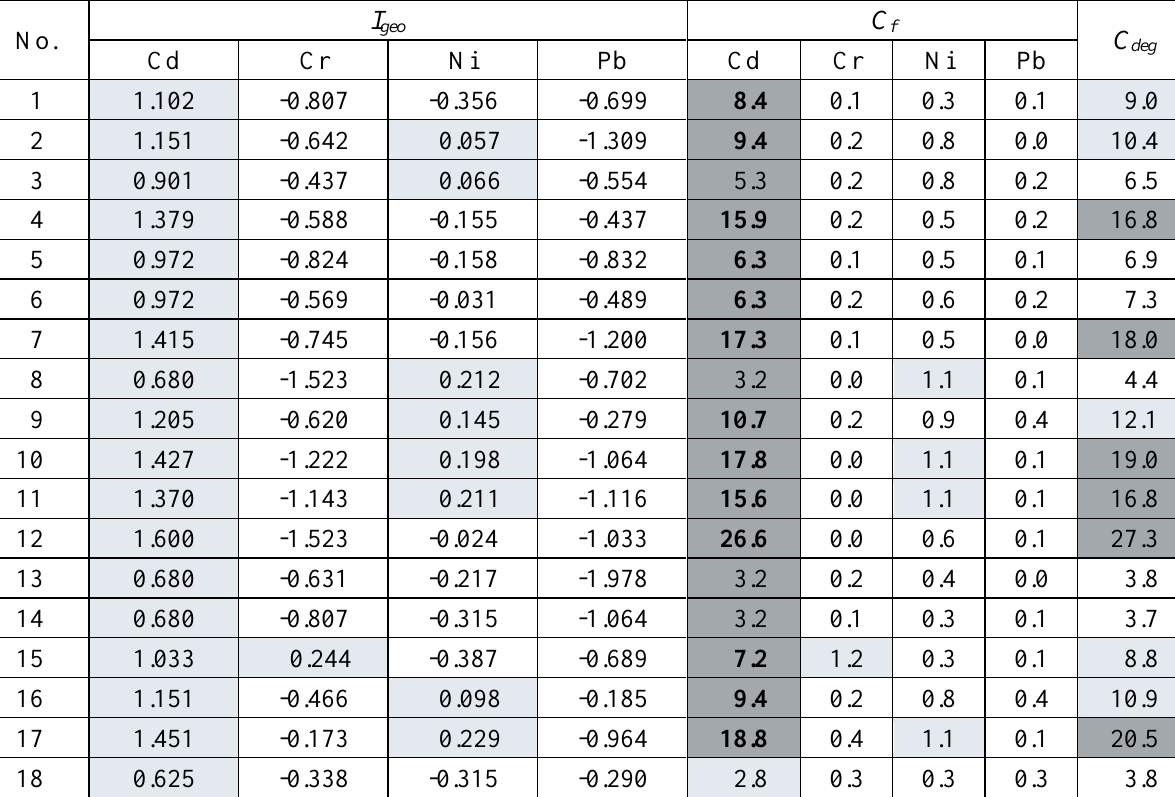
Table 3. Geoaccumulation index ( I geo ) and contamination factor ( C f ) for individual trace elements, and the degree of contamination ( C deg ), in transitional mires on Bolshoy Solovetsky Island. Shading indicates certain levels of a each index, as follows: I geo : not shaded = definitely unpolluted samples, light grey background = low to moderately polluted samples; C f : white = C f < 1 indicating low contamination, light grey corresponds to 1 ≤ C f < 3 which is considered to indicate moderate contamination, dark grey indicates 3 ≤ C f < 6 i.e. considerable contamination, shaded dark grey and printed in boldface means C f ≥ 6 which is a very high contamination factor; C deg : no shading = a low pollution level, light grey = moderate, and dark grey = a considerable degree of